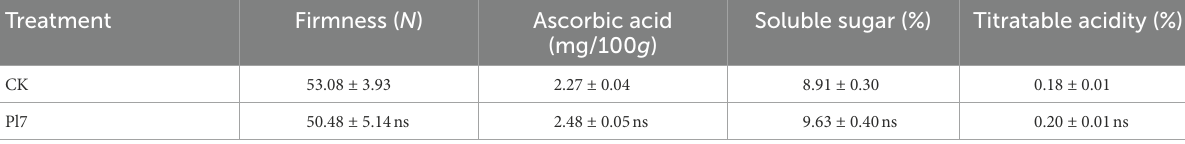
TABLE 1 Effect of B. halotolerans strain Pl7 on apple postharvest